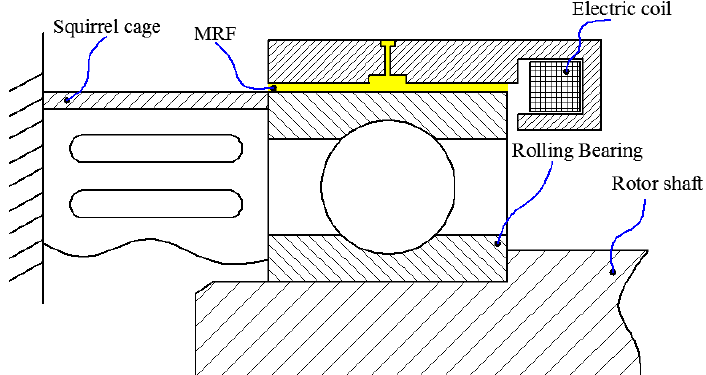
Figure 4. Schematic diagram of the rotor supporting system.